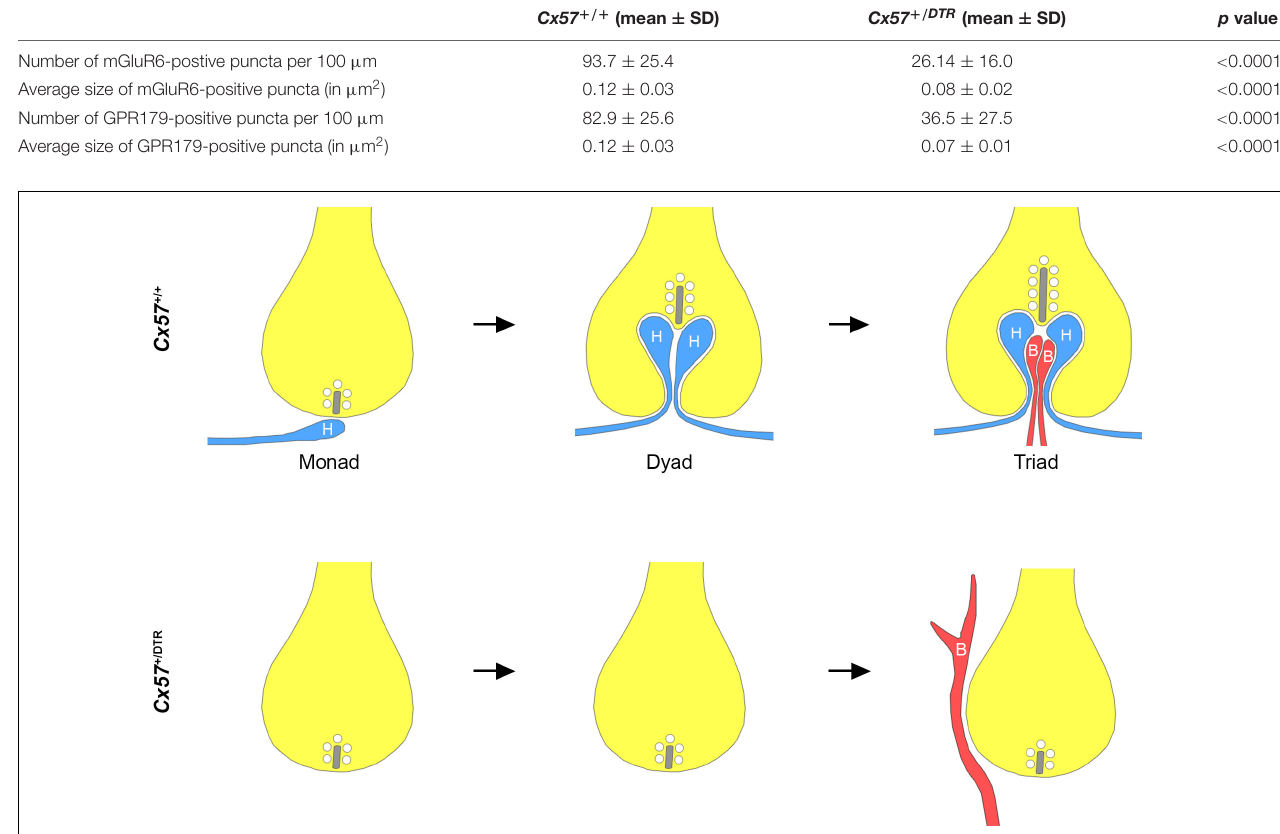
FIGURE 5 | Schematic illustration of rod synaptogenesis in wild-type and horizontal cell-ablated mice. In the wild-type retina, the rod terminal is initially contacted by a single horizontal cell process (H). The following day, another horizontal cell process is recruited and both invaginate into the terminal, occupying the positions lateral to the presynaptic ribbon. Subsequently, one or two ON bipolar cell dendrites (B) insert between the two horizontal cell processes. In the absence of horizontal cells, rod bipolar cell dendrites are not able to invaginate into the rod terminal and sprout into the ONL. Synaptic ribbons, if present, are shorter compared to wild-type